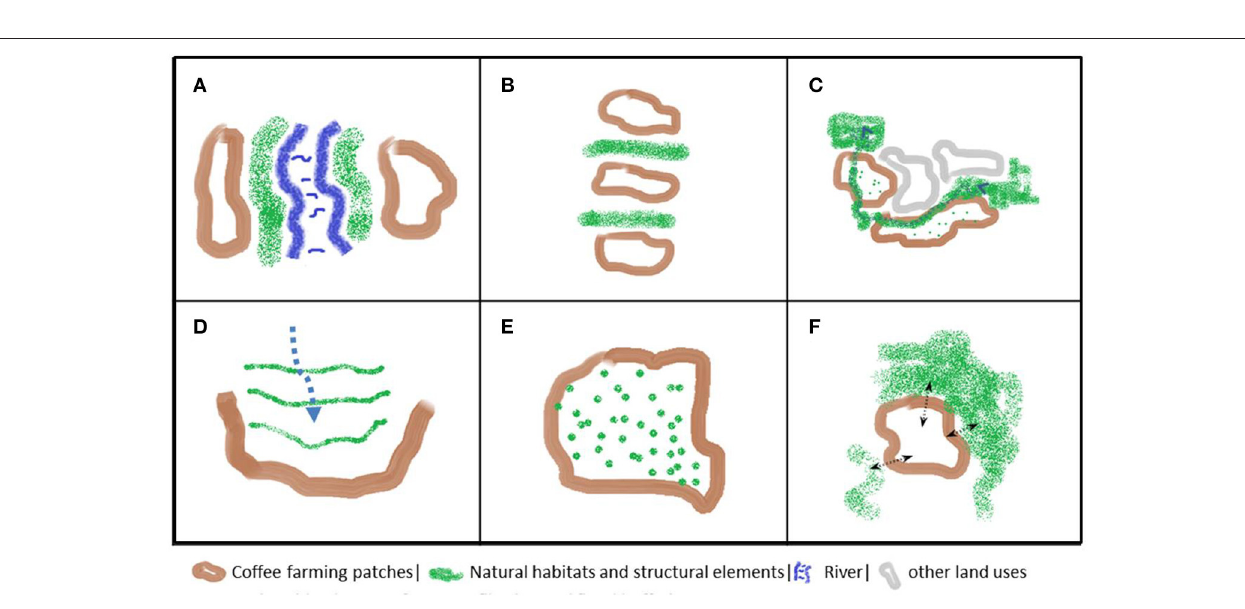
FIGURE 3 | Spatial patterns influencing landscape service delivery. (A) Green riverside elements for water filtering and flood buffering. (B) Forest blocks as separation between coffee patches, slowing down wind speeds and disease spread (e.g. coffee rust). (C) Joining natural in-field elements for enhanced habitat connectivity and creation of natural corridors. (D) Orthogonal arrangement of blocked structural elements to slow down wind and/or water erosion, as well as to protect from strong winds. (E) Integrating natural elements on-farm for highest diversity and landscape permeability. (F) Maintaining natural habitats in neighboring areas to allow positive spill-over effects (pollination, natural pest control). Own elaboration, based on Goldman et al.